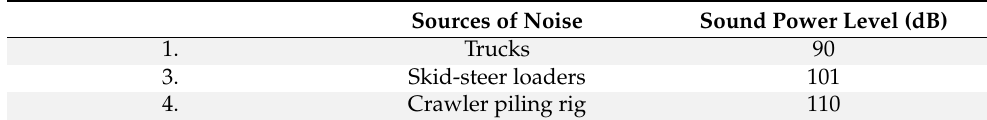
Table 13. Expected sources of construction noise.